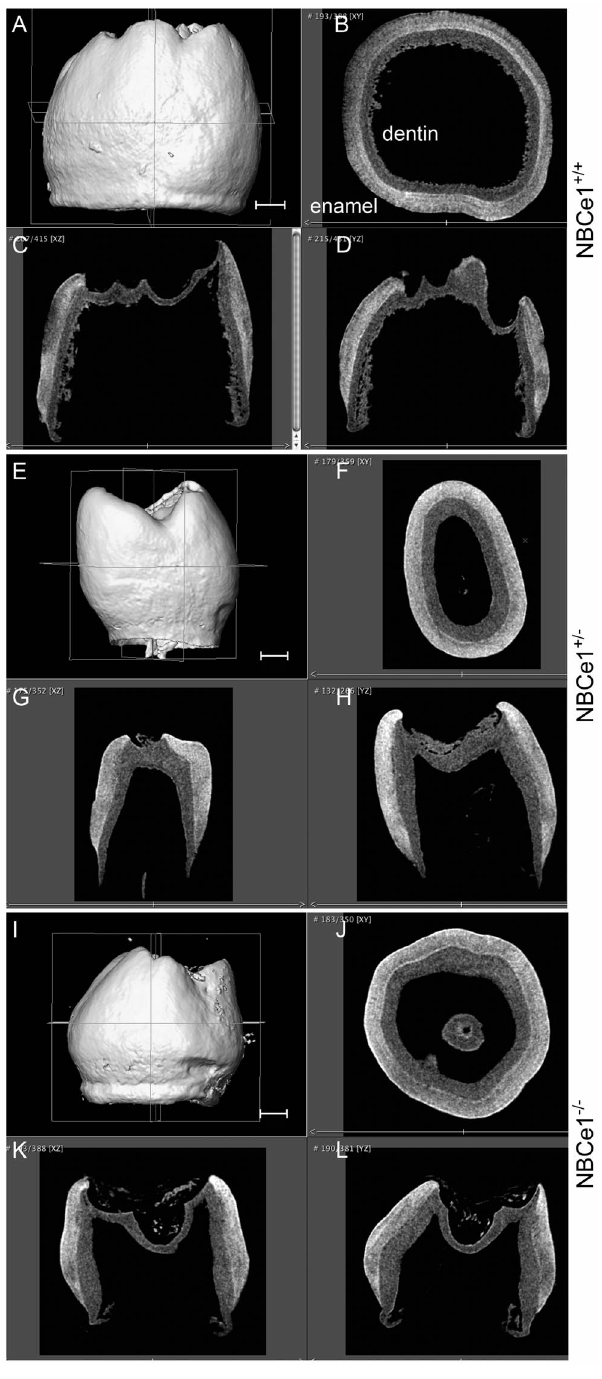
Figure 1. NBCe1 + / + (panels A–D), NBCe1 + / 2 (panels E–H) and NBCe1 2 / 2 panels (I–L) teeth at age E11.5 + 70 in host kidney capsules. Micro-CT three-dimensional (3D) images (panels A, E and I) and cross-sectional slices (panels B–D, F–H and J–L) of three typical examples of teeth grown underneath kidney capsule. Avizo software was used to analyze m CT data. Scale bars shown in panels A, E and I are 100.0 m m and are common to panels A–D, E–H and I–L respectively. doi:10.1371/journal.pone.0097318.g001 two to three layers of cells form the stratum intermedium between the ameloblast monolayer and stellate reticulum. The origins of the stratum intermedium cells are unclear, but there is evidence